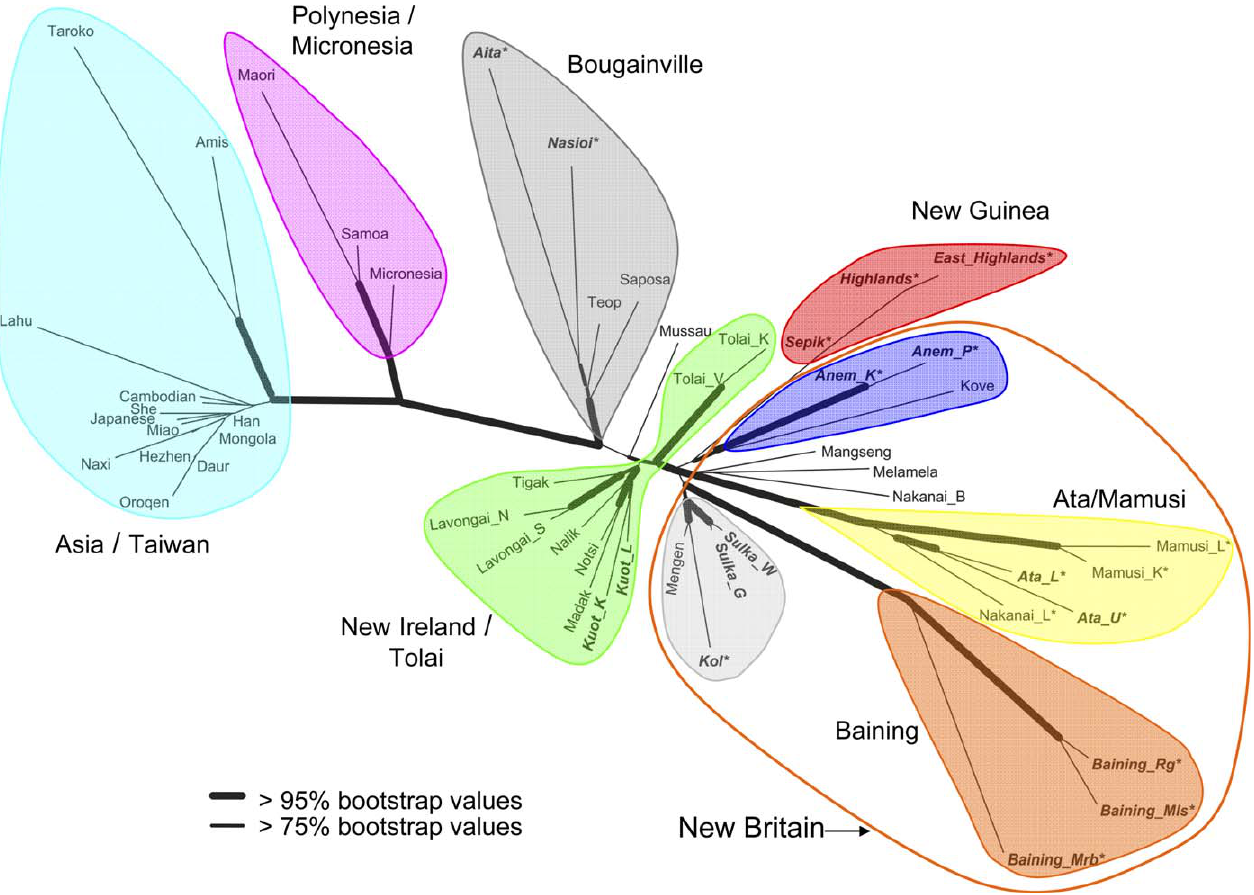
Figure 9. Pacific Population Tree Neighbor-joining F ST -based tree for 687 microsatellites from the Pacific, East Asia, and French populations, with the range of bootstrap values indicated by branch thicknesses. Colors are the same as in the STRUCTURE analysis at K ¼ 10. New Britain populations are circled. Papuan-speaking groups are in bold italics; inland groups in Melanesia have asterisks. Abbreviated names are spelled out in Table S1.